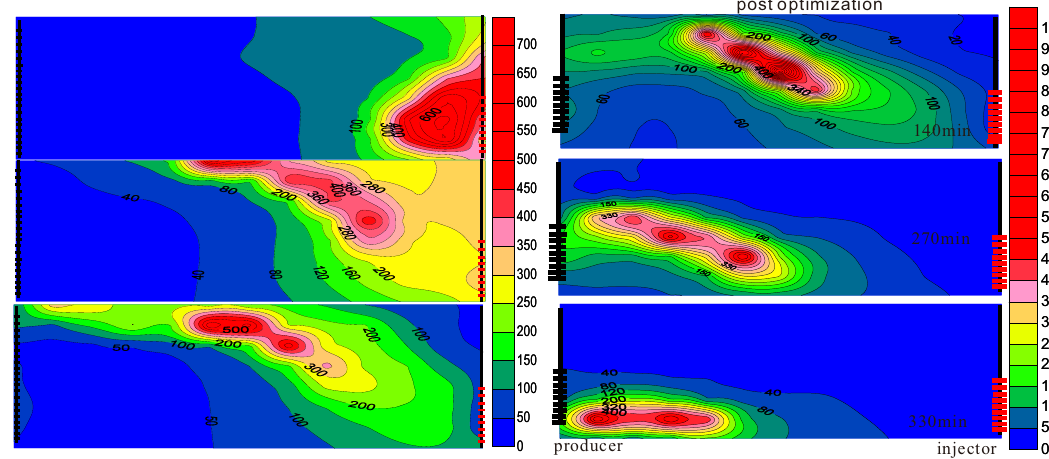
Fig. 9 The combustion front propagation in the model for 60 m pay